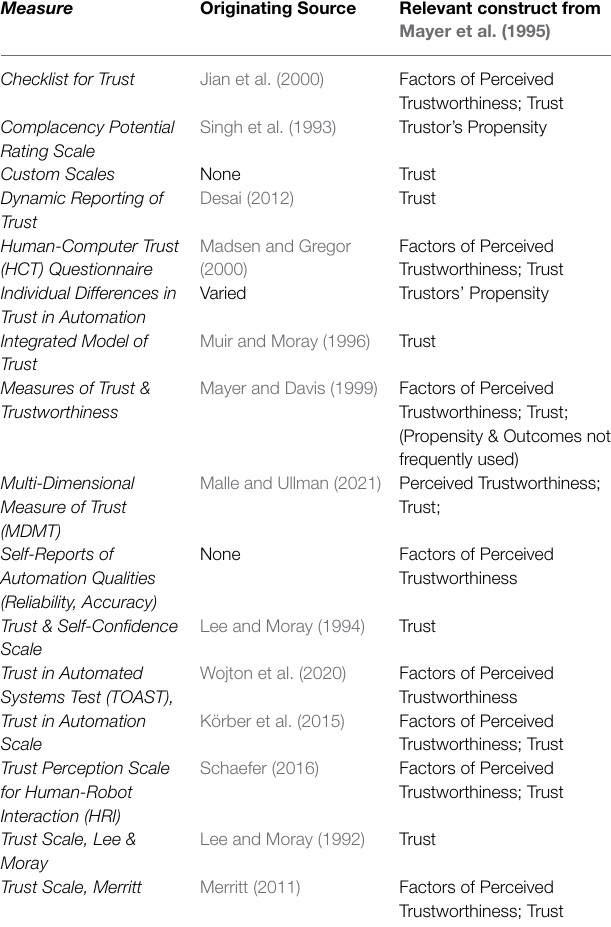
TABLE 3 | Self-report measures of